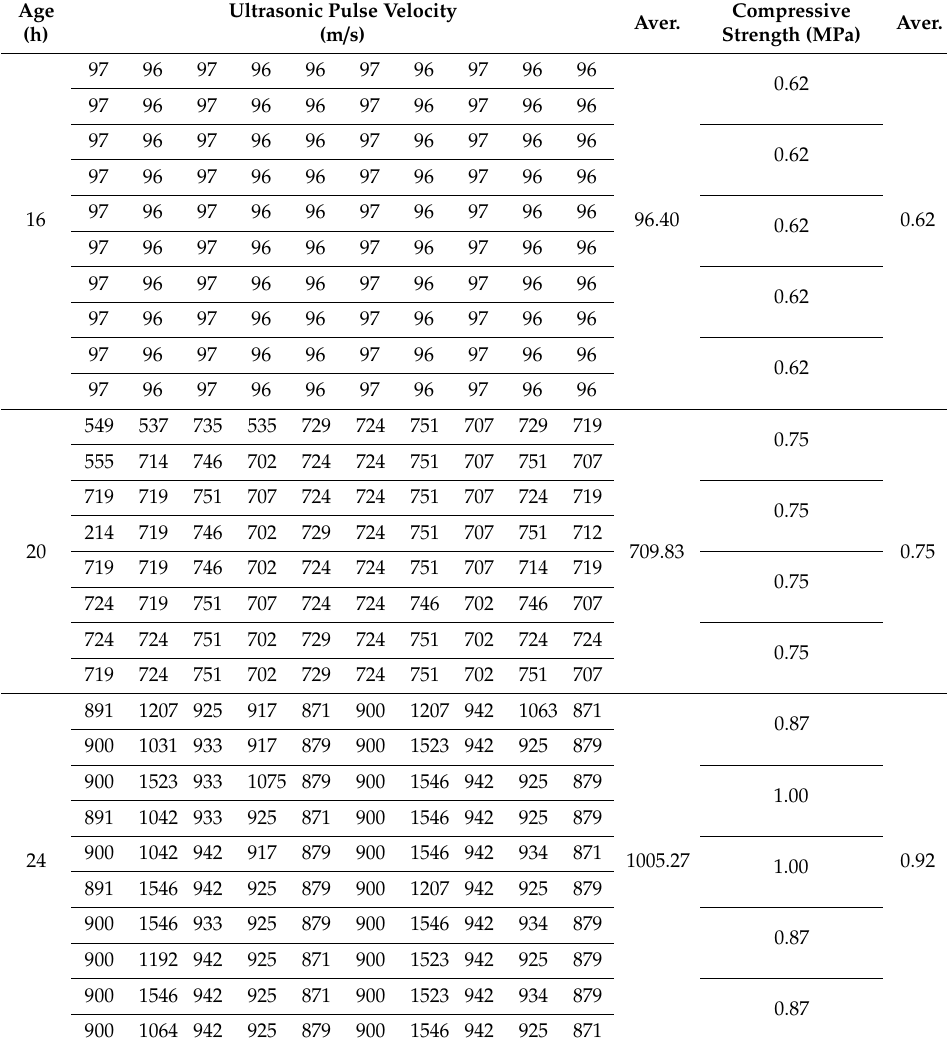
Figure 4. Ultrasonic pulse velocity with age (24 MPa). Table 2. Experiment results.